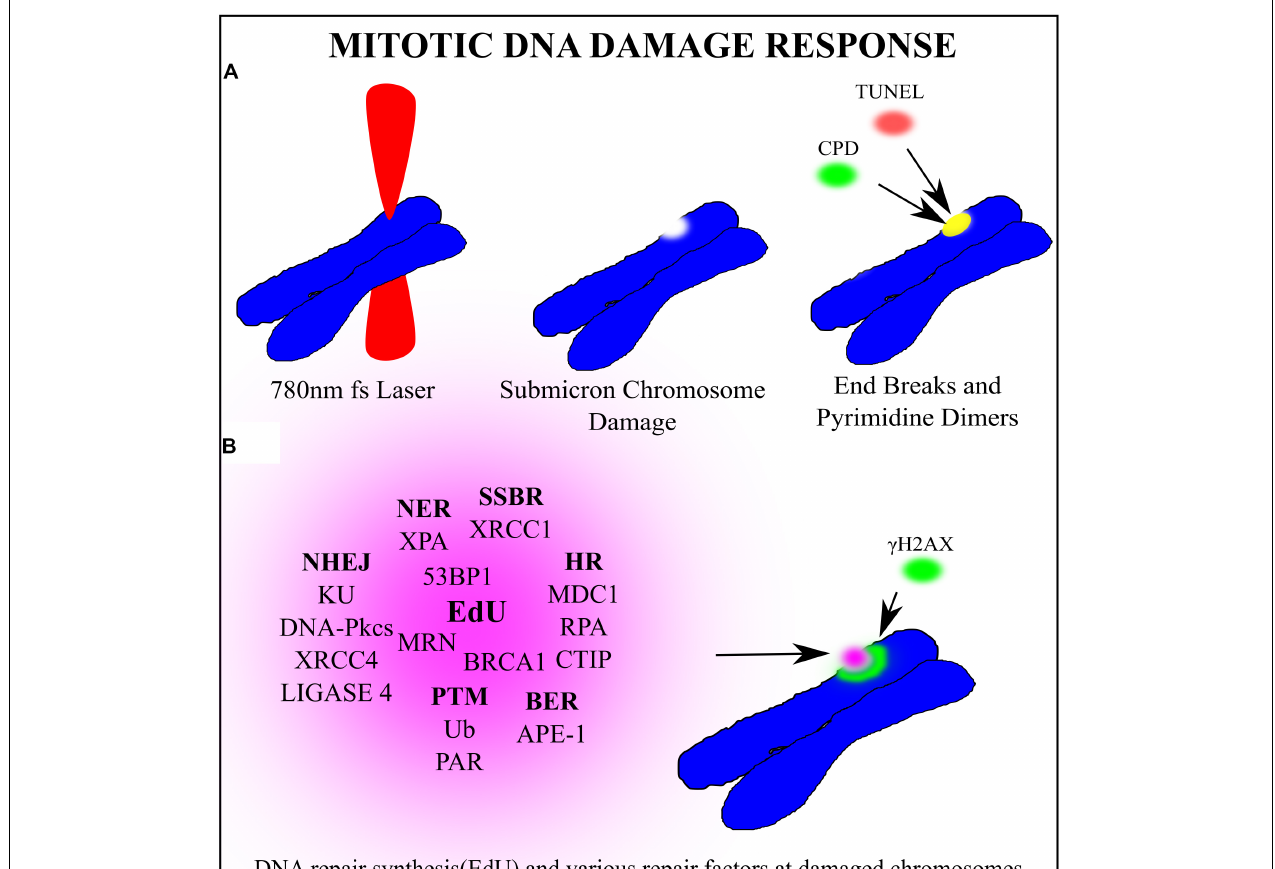
FIGURE 11 | General schematic of a laser microbeam DNA repair experiment on a chromosome in a dividing cell. (A) A 780 nm femtosecond laser is focused to a sub-micron region on a mitotic chromosome. End breaks detected via TUNEL assay and cyclo-butane pyrimidine dimers were found at the laser damage site. (B) Several factors clustered to the damage site. In bold are the repair pathway abbreviations that each factor is most closely associated with. Non-Homologous End Joining (NHEJ), Single Strand Break Repair (SSBR), Base Excision Repair (BER), Homologous Recombination (HR) Post translational modifications (PTM), Nucleotide excision repair (NER). DNA synthesis occurs at the damaged chromosome region as detected via EdU incorporation. Phosphorylated Histone γ H2AX on Serine 139 marks double strand breaks and extends from the laser damage spot. Based on the recruitment of the corresponding proteins, it is hypothesize that these repair pathways may be activated during